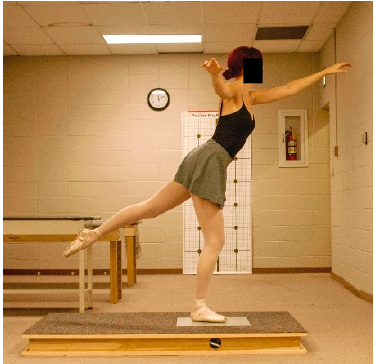
Figure 9. Jumping landing in pli é on the force plate for sissonne ouverte an